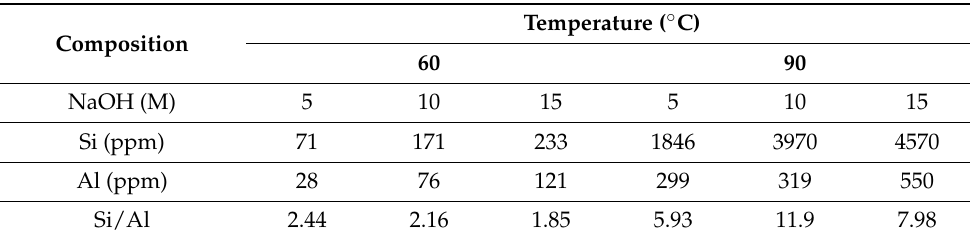
Table 4. Si and Al concentrations in the geopolymer at different curing temperatures and NaOH concentrations